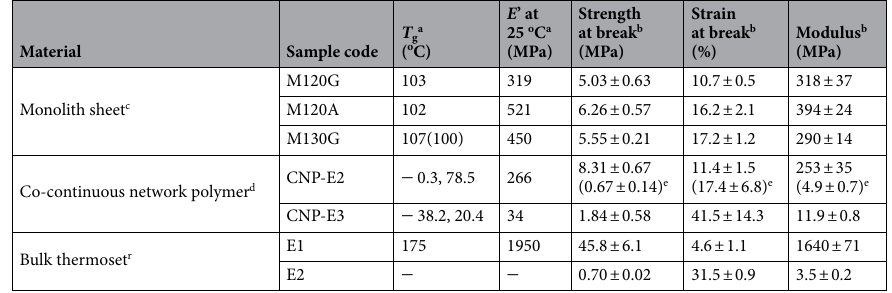
Table 1. Thermal and mechanical properties of the monolith sheets, the CNPs with E2 and E3, and the bulk thermosets of E1 and E2. a Based on tanδ peak temperature of DMA measured at the frequency of 1 Hz and the heating rate of 2 °C/min. Values in parentheses indicate T g values determined by DSC from the second heating process at the heating rate of 10 °C/min. b Based on the tensile test at the rate of 1 mm/min and room temperature. Modulus was determined in the strain range of 0.05–0.25% c M120G and M120A were prepared on glass and Al plates, respectively, at 120 °C. M130G was prepared on a glass plate at 130 °C. d CNP-E2 and CNP-E3 were prepared using M120A as the monolith sheet. e Values in parentheses indicate those determined at 80 °C. f Bulk thermoset prepared by thermal curing of an epoxy resin (E1 or E2) with BACM in the absence of PEG200 as the porogen.